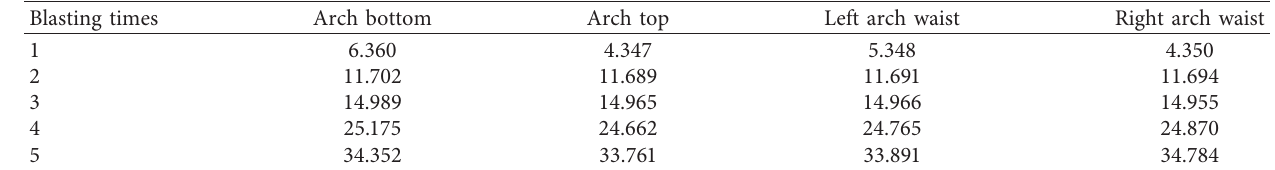
Table 6: Peak value of vibration velocity at each measuring point of profile 3-3 (10 − 2 m/sec). Blasting times Arch bottom Arch top Left arch waist Right arch waist